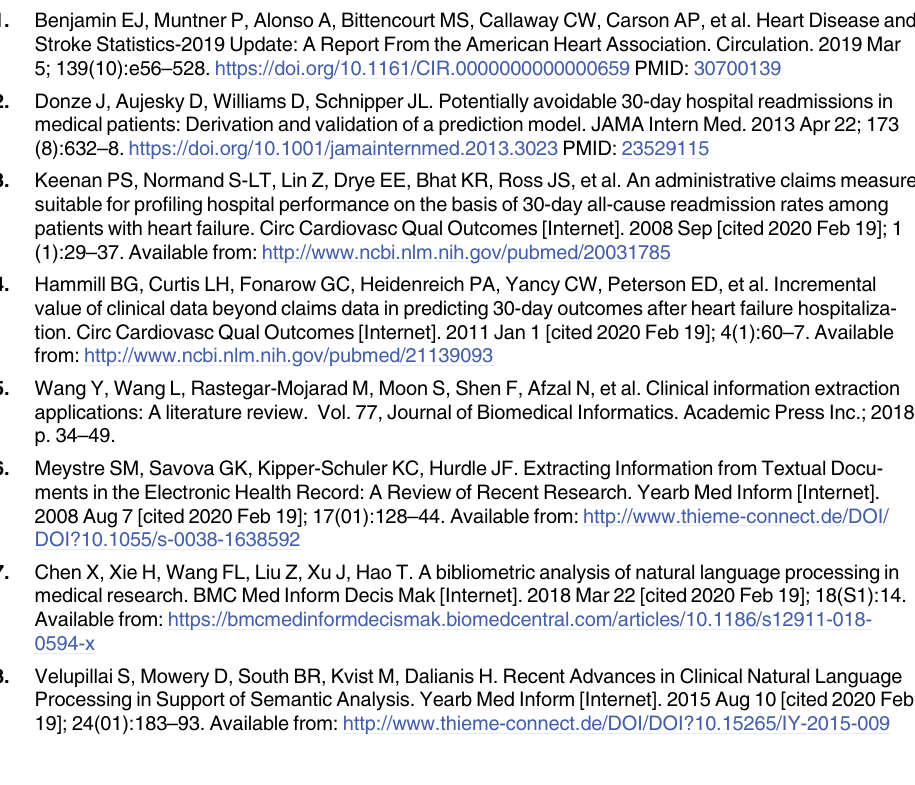
S1 Table. (A) Full Cox model for correlation between the radiographic finding and all-cause mortality. (B) Select Cox model and correlation between radiographic findings and all-cause